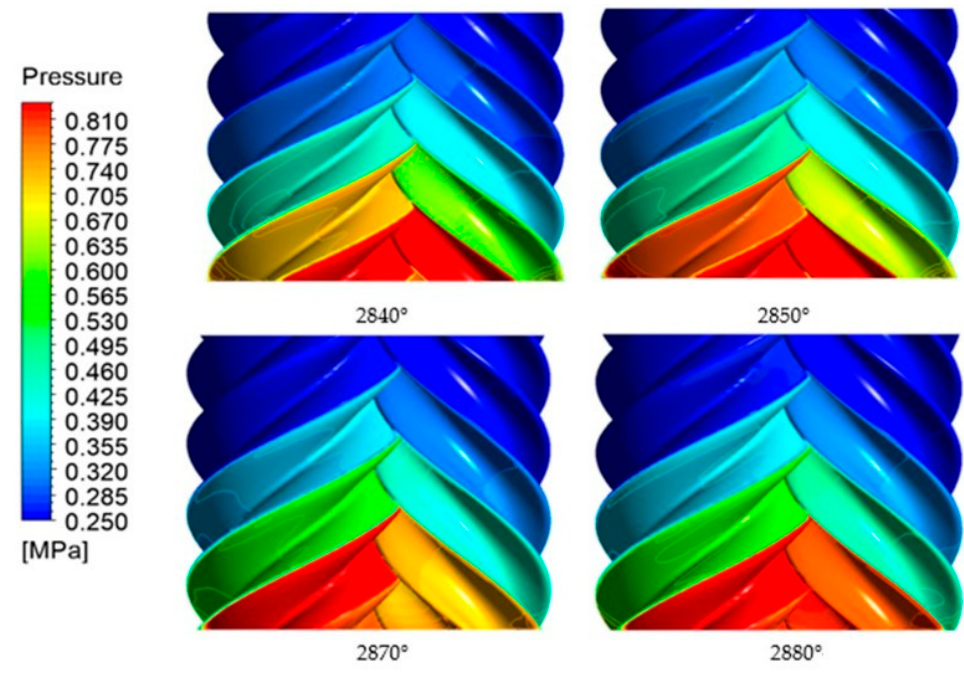
Figure 6. Pressure contours on the rotors at different angles.